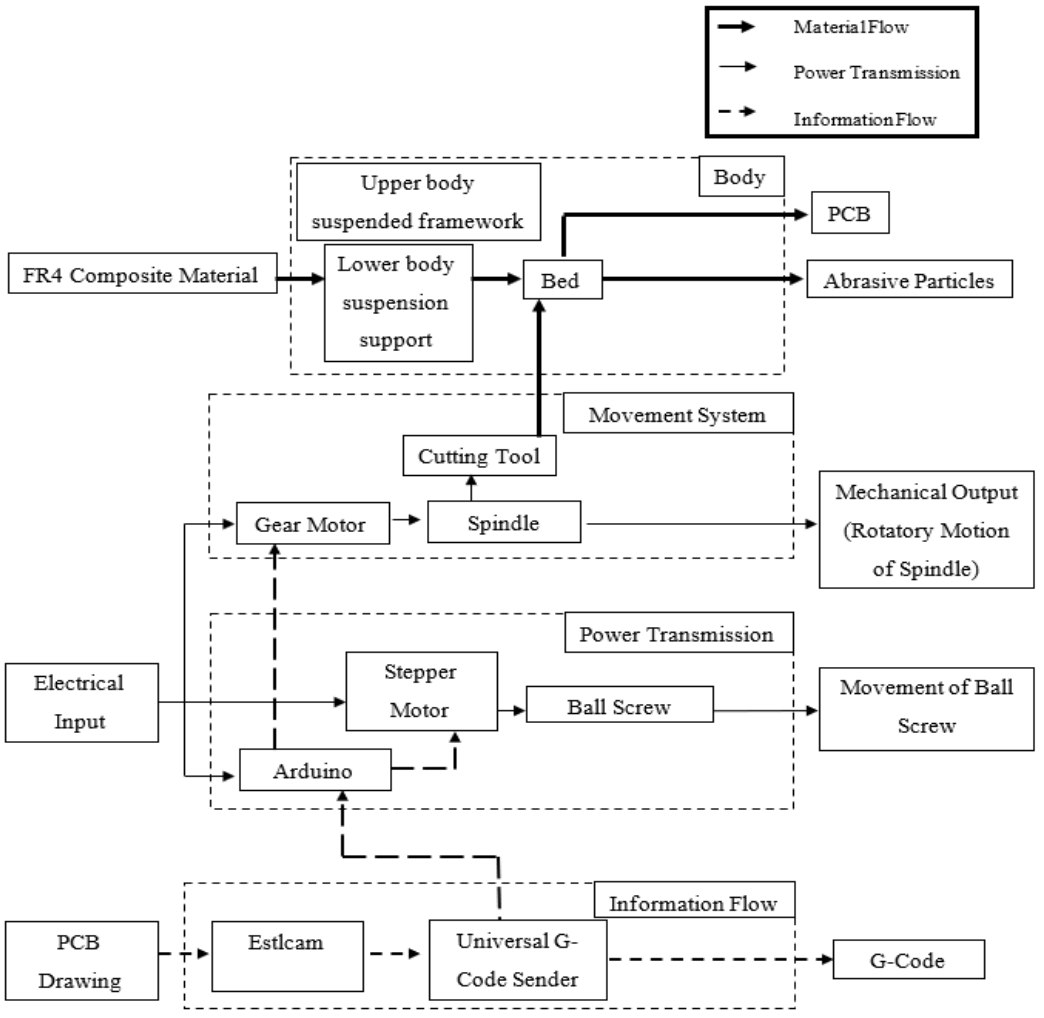
Figure 4. Cluster function structure for CNC PCB